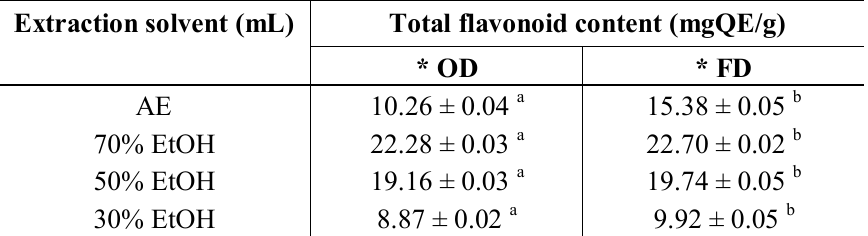
Table 2. Total flavonoid constituents of S. asper leaves aqueous and ethanol extract from oven dried (OD) and freeze dried (FD)